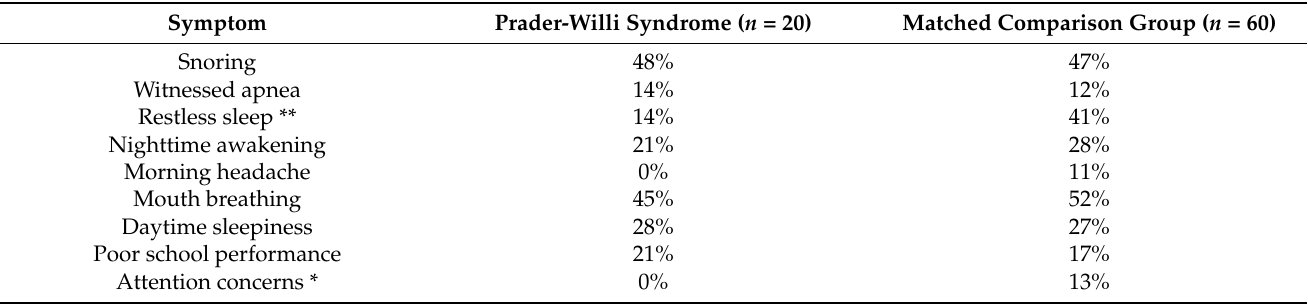
Table 2. Sleep-related symptoms in children with Prader-Willi syndrome and matched comparison